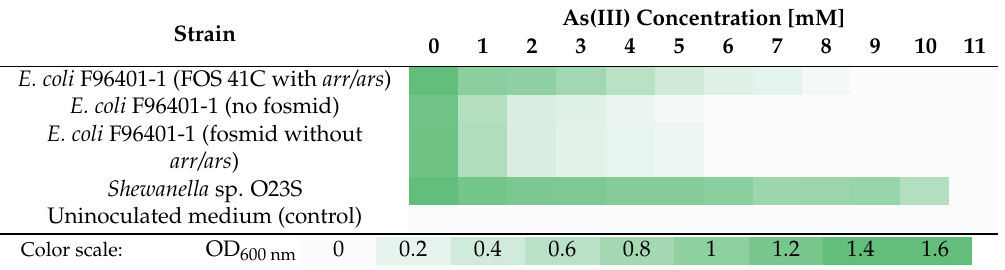
Table 2. Growth of strains with and without the arr/ars module on LB medium supplemented with As(III) under aerobic conditions. Heatmaps reflect the intensity of growth.